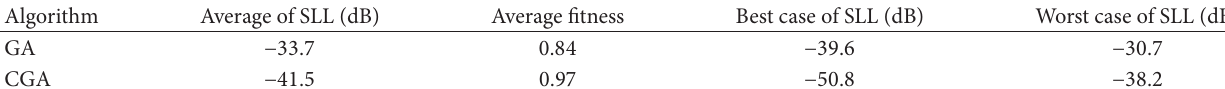
Table 1: Simulation results of the algorithms.